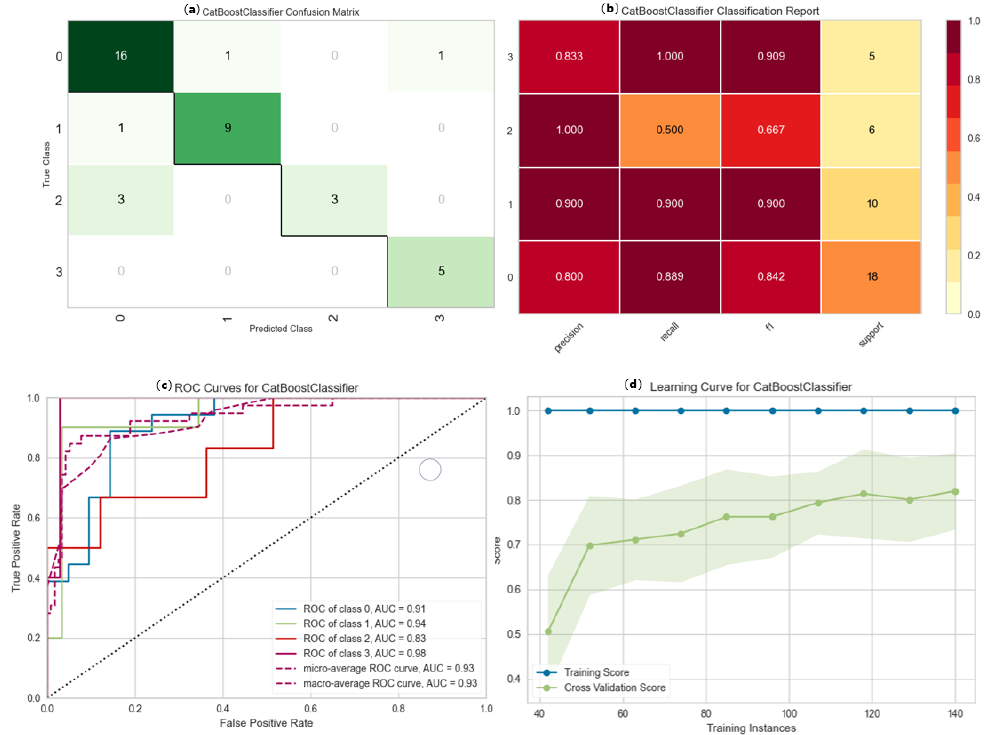
Figure 12. CatBoost algorithm. Evaluation metrics.